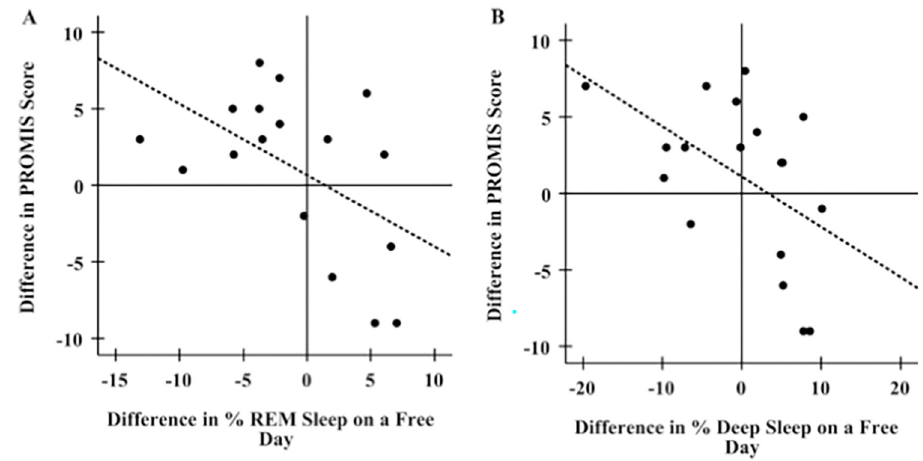
Fig 4. Association of the differences in PROMIS scores mid-pandemic versus pre-pandemic with differences in STAI and BDI scores. Increases in sleep disturbance scores during the pandemic are positively associated with increases in (A) anxiety scores (R 2 = 0.258, β = 0.508, p = 0.045) and (B ) BDI scores (R 2 = 0.305, β = 0.552, p = 0.022).